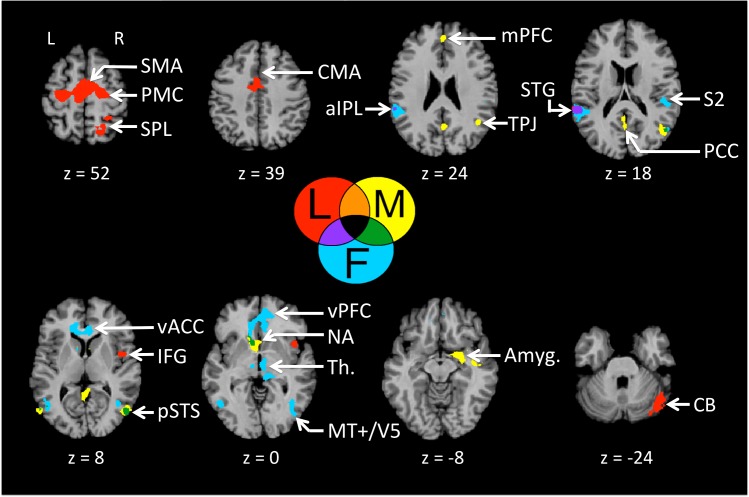
Specificity for Leading, Following, and Mutual.Neural specificity for Leading, Following and Mutual is shown, after removing both basic motoric effects (through subtraction of the non-partnered conditions Solo + Alone) and partnering effects, as seen in a conjunction of the three partnership contrasts: [Leading > non-partnered conditions] ∩ [Following > non-partnered conditions] ∩ [Mutual> non-partnered conditions]. The role-specific activations are color-coded as follows: Leading (red): [Leading > Non-partnered conditions] > [Partnership Conjunction]; Following (blue): [Following > Non-partnered conditions] > [Partnership Conjunction]; and Mutual (yellow): [Mutual> Non-partnered conditions] > [Partnership Conjunction]. The results are p < 0.005 uncorrected, with a cluster threshold k = 20. Abbreviations: aIPL: anterior inferior parietal lobule; MCC: middle cingulate cortex; MT+/V5, motion area of the middle temporal region; mPFC: medial prefrontal cortex; NA: nucleus accumbens; pSTS: posterior superior temporal sulcus; S1: primary somatosensory cortex; S2: secondary somatosensory cortex; TPJ: temporo-parietal junction.